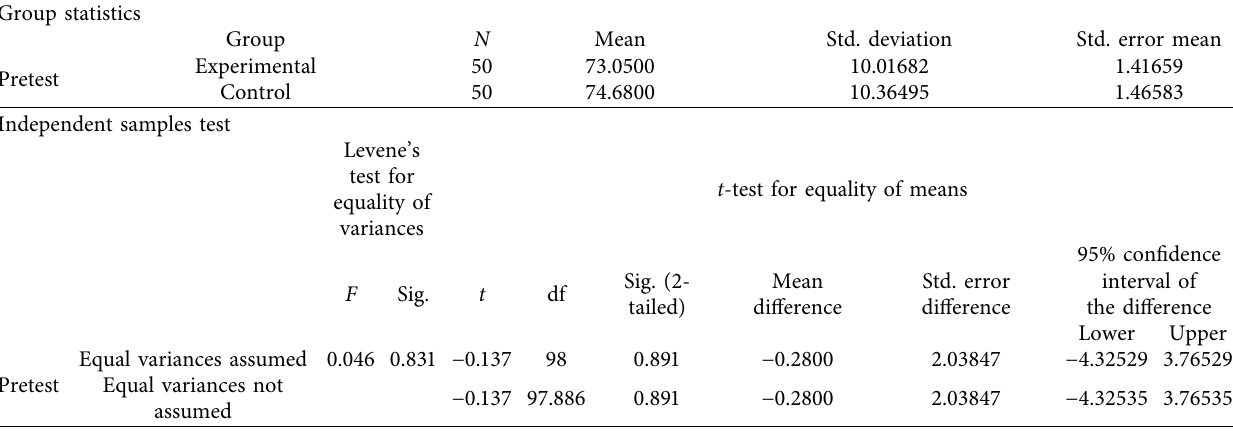
Table 2: Pretest results and